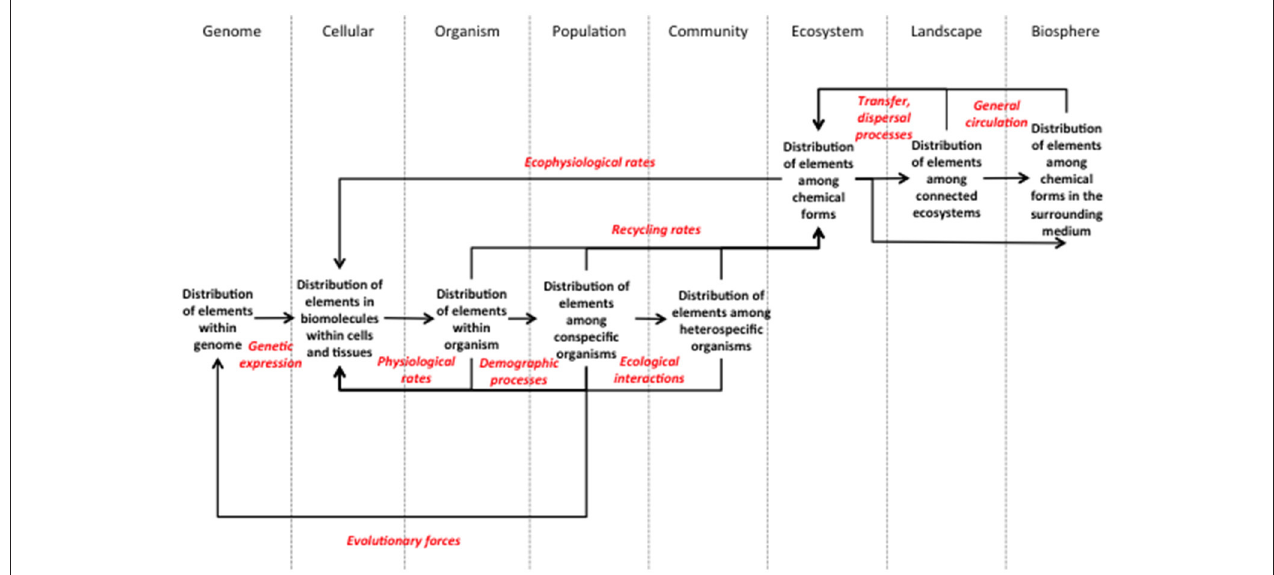
FIGURE 1 | Framework for a molecule-to-biosphere stoichiometry theory. This framework presents explicitly the biological levels and processes that need to be investigated in order to characterize the repercussions of a stoichiometric imbalance at one level over all the other levels. Each biological level should be described by the patterns of elemental distribution within it. As the framework shows, the processes investigated should go beyond the fluxes and rates of elements between components that are classically considered in stoichiometric studies. Any process affecting the structure of a biological level should be considered if the changes provoked relate to changes in the distribution of elements. Numerous examples are discussed within the